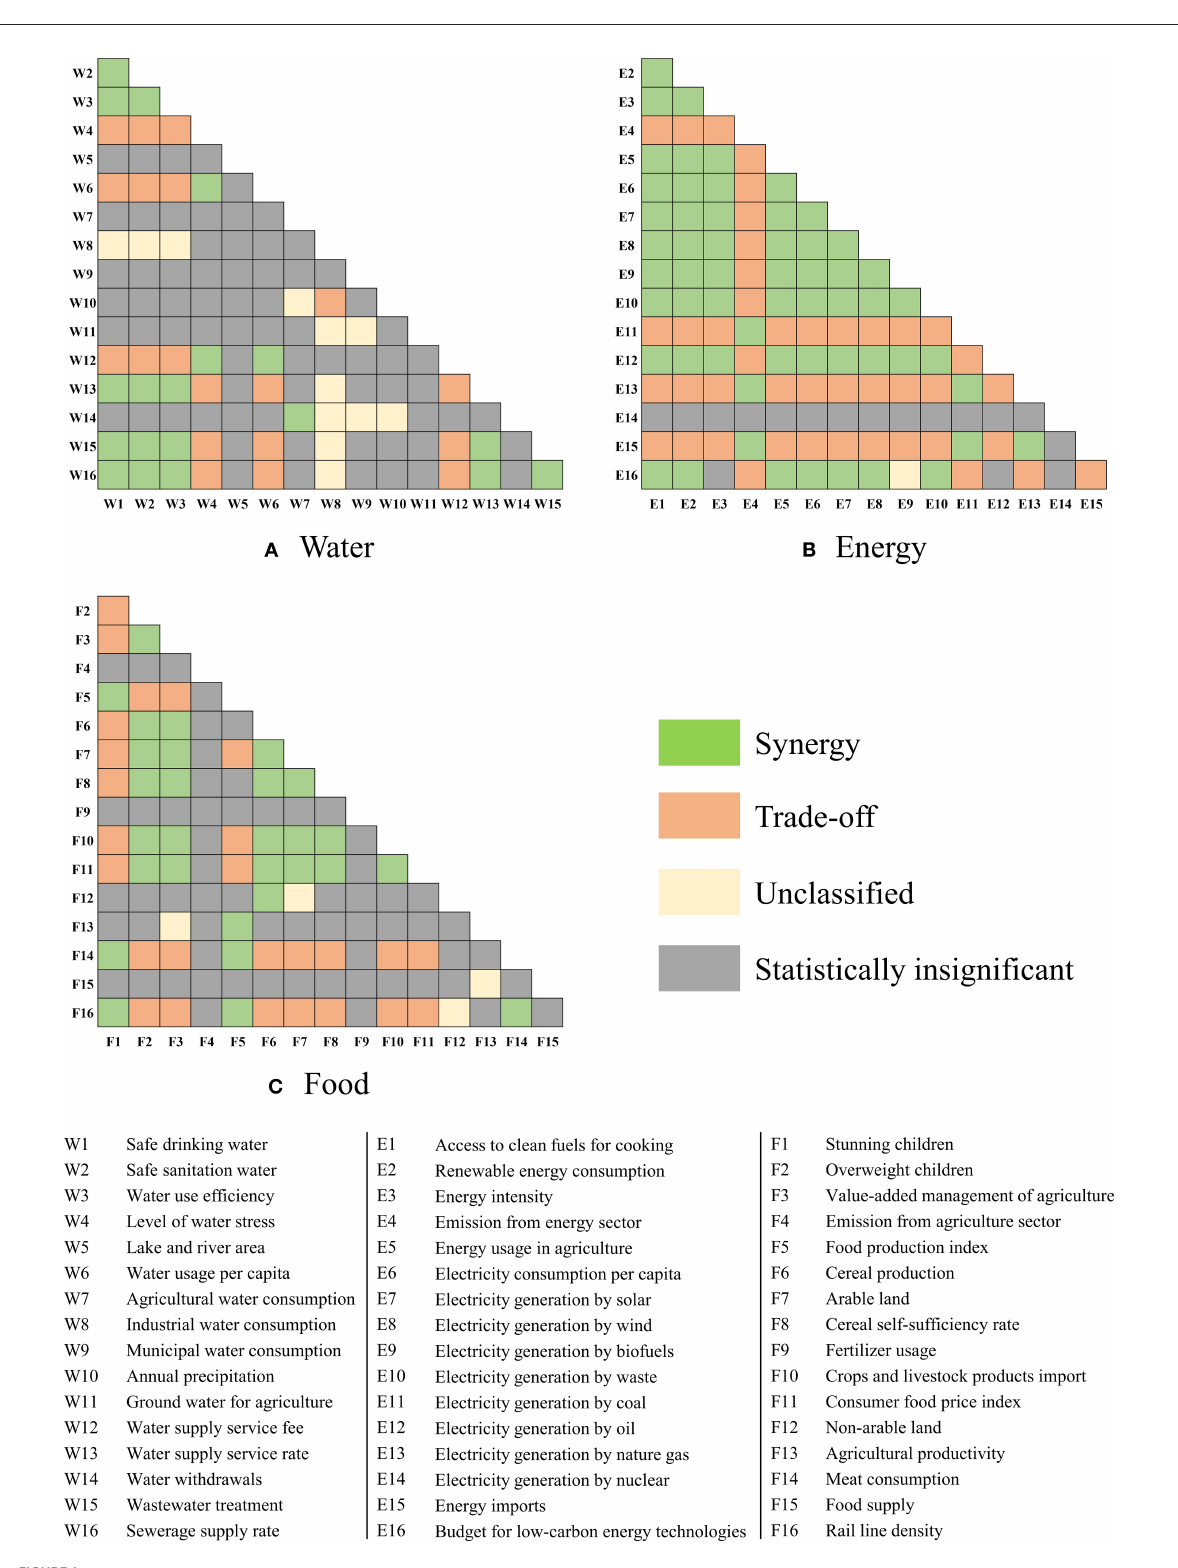
FIGURE1 Interactions within water, energy, and food (WEF) security indicators in South Korea: (A) Interactions within water security indicators, (B) interactions within energy security indicators, and (C) interactions within food security